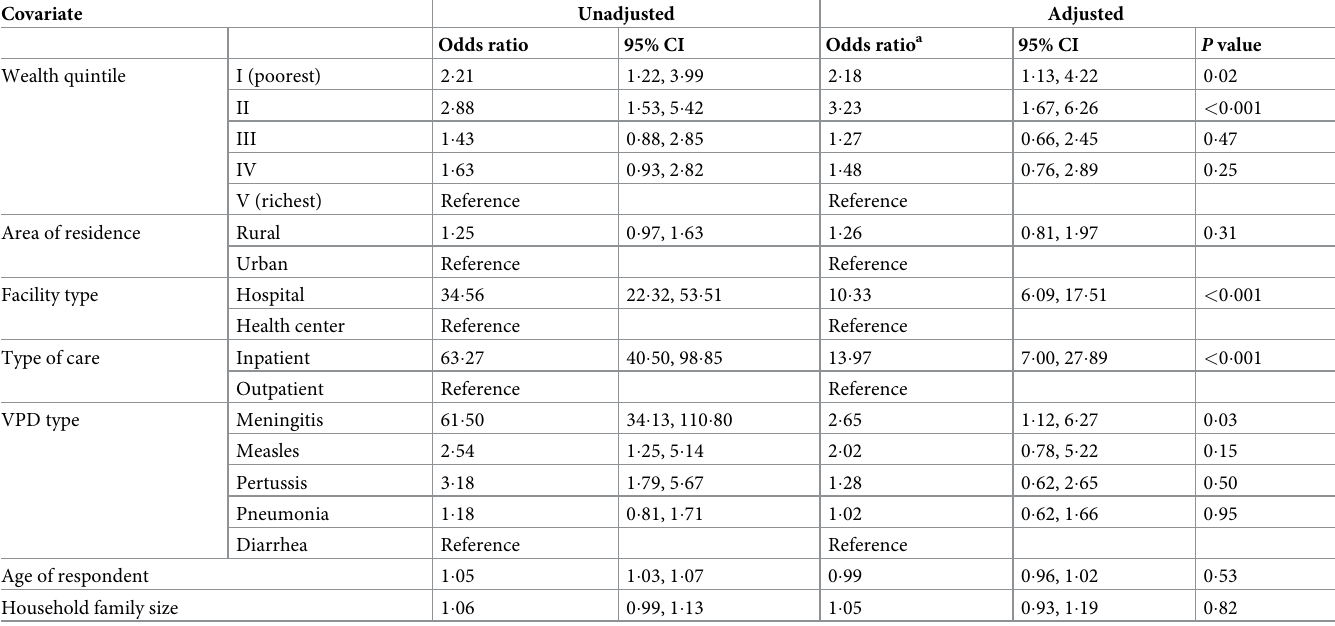
Table 5. Factors associated with odds of CHEs for VPDs.